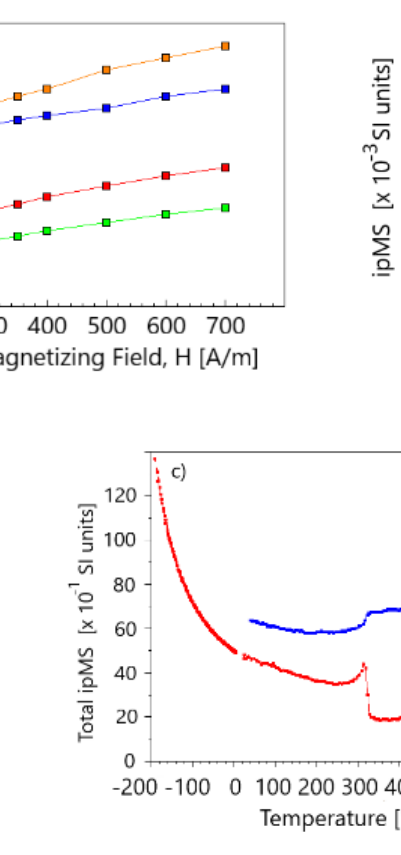
Figure 12. Variation of opMS with magnetizing field ( a ), variation of ipMS with field ( b ), variation of ipMS with temperature ( c ) (in red—heating curve, in blue—cooling curve) in the locality of Hut ě .